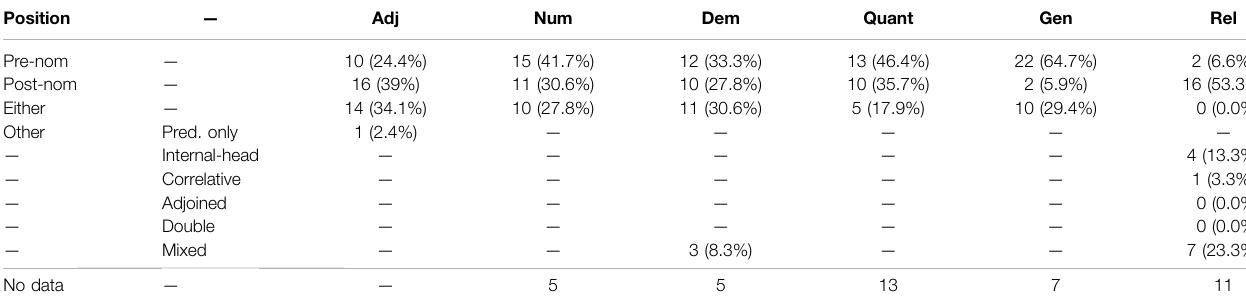
TABLE 2 | Overall Word Order Typology of SLs (percentages based on SLs with data). Position